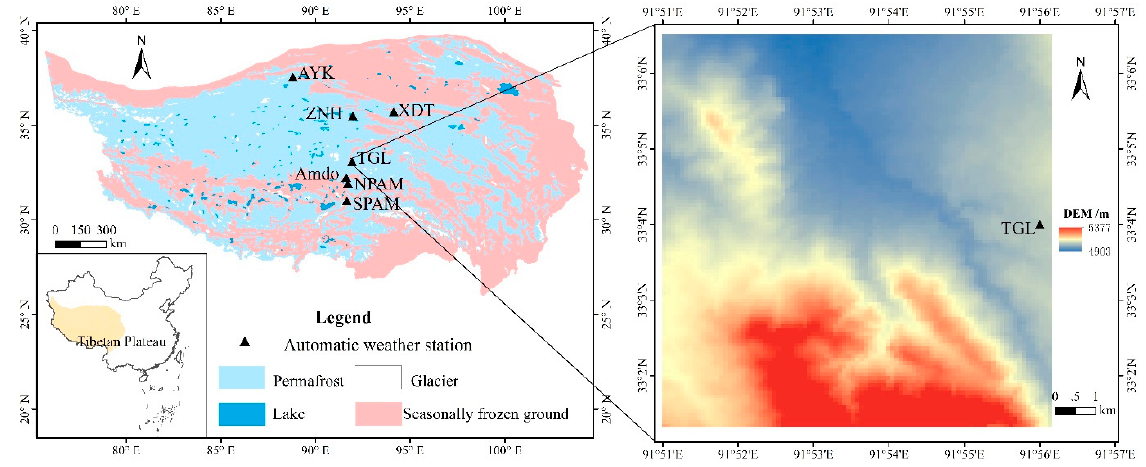
Figure 1. Map of the distribution of observation sites.